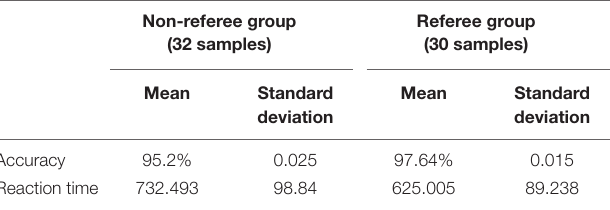
TABLE 2 | Statistical description of decision-making accuracy and reaction time of two groups of participants.